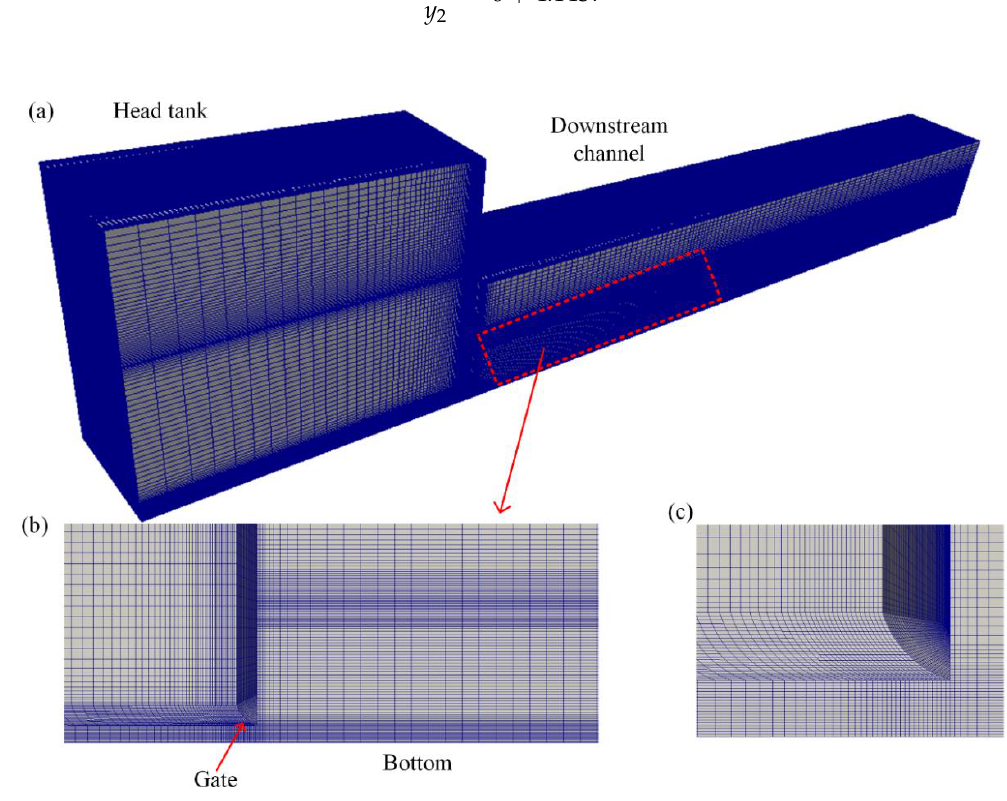
Figure 4. Block-structured computational mesh: (a) three-dimensional view of the mesh in the computational domain; (b) front view of the mesh in the roller region; (c) zoomed-in view of the gate lip.